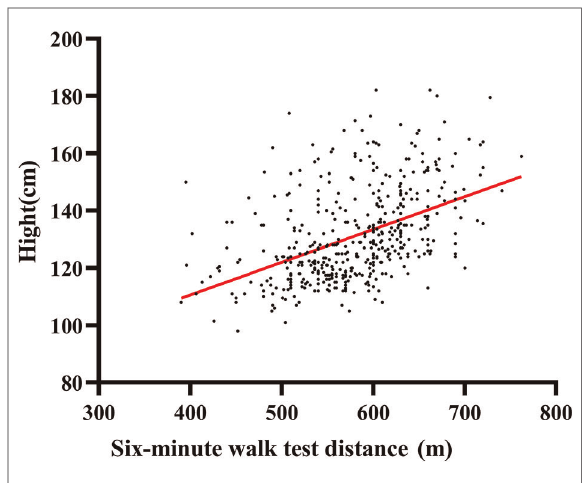
FIGURE 2 Scatter plots of the relationship between the six-minute walk test (6MWT) distance and height of children and adolescents with congenital heart disease. The red straight line in the scatter plots is linear regression fi